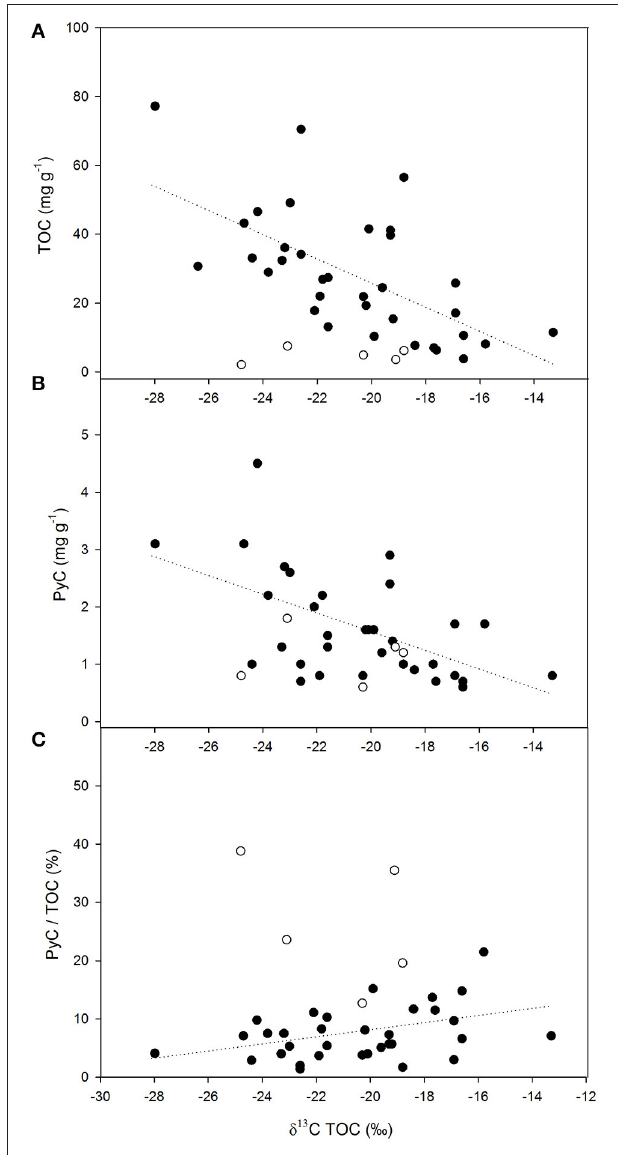
FIGURE 3 | Relationships between δ 13 C values of bulk sediment samples and: (A) TOC content (mg g − 1 ), r 2 0.40; p < 0.05 ; (B) PyC content (mg g − 1 ), r 2 0.37; p < 0.05; and (C) the relative contribution of PyC to TOC (%), r 2 0.15; p < 0.05. Total number of samples is 38. Open symbols correspond to samples with very coarse texture ( n = 5). These were not included in the